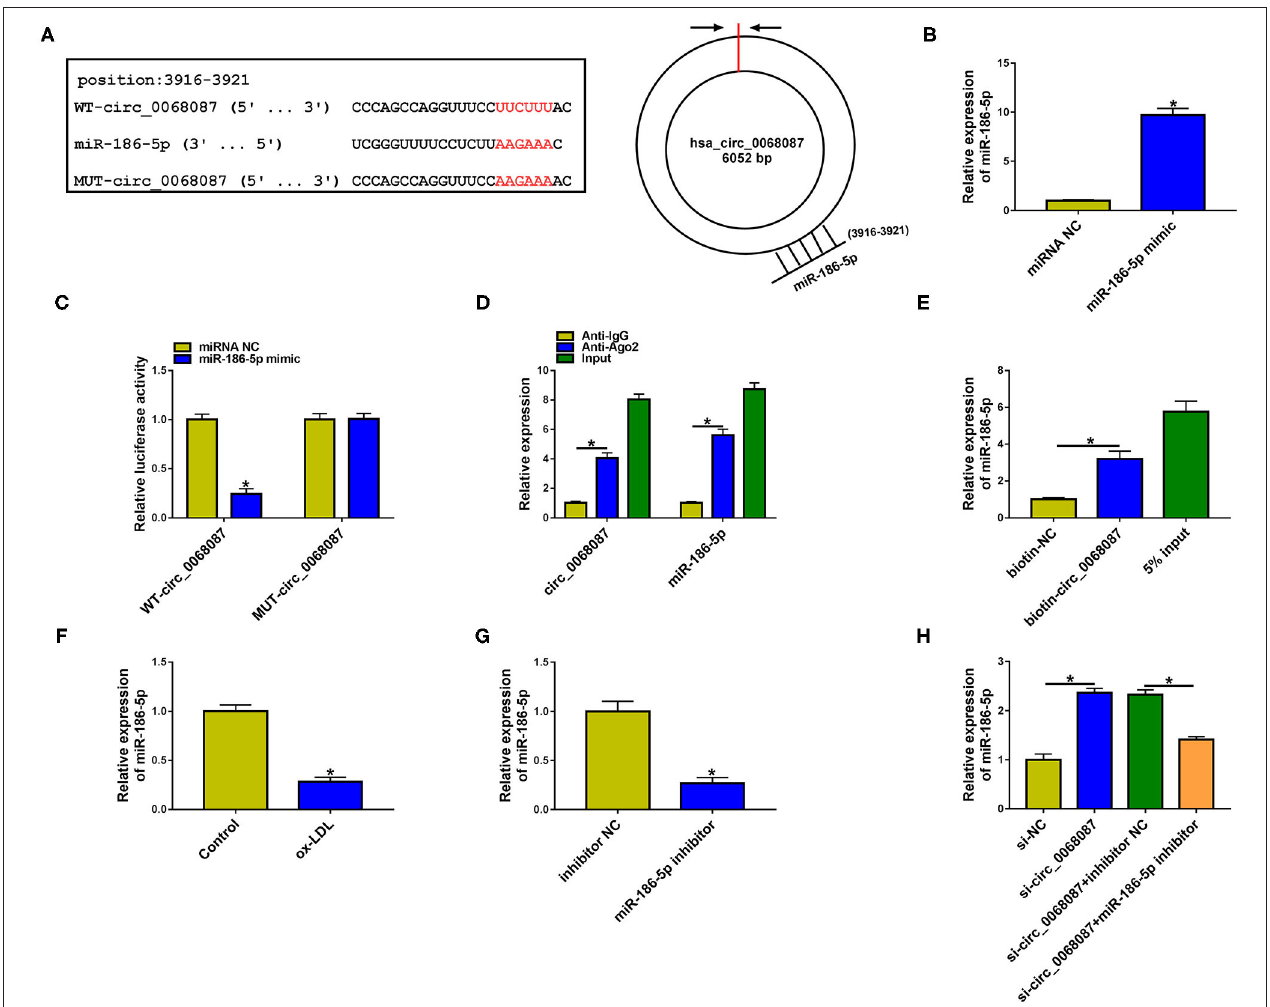
FIGURE 3 | Circ_0068087 acts as miR-186-5p sponge in HUVECs. (A) The putative binding sites between circ_0068087 and miR-186-5p were predicted by circinteractome and circBank. (B) The overexpression efficiency of miR-186-5p mimic in HUVECs was assessed by RT-qPCR. This experiment was performed three times with three technical repetitions each time. An unpaired Student t -test was used to evaluate the differences. (C,D) The predicted interaction between circ_0068087 and miR-186-5p was tested by dual-luciferase reporter assay and RIP assay. These two experiments were performed three times with three technical repetitions each time. An unpaired Student t -test was used to evaluate the differences. (E) RNA pulldown assay was applied to test the interaction between circ_0068087 and miR-186-5p. This experiment was performed three times with three technical repetitions each time. An unpaired Student t -test was used to evaluate the differences. (F) The level of miR-186-5p was measured in HUVECs exposed to 40 mg/L ox-LDL for 24h by RT-qPCR. This experiment was performed three times with three technical repetitions each time. An unpaired Student t -test was used to evaluate the differences. (G) The silence efficiency of miR-186-5p inhibitor in HUVECs was assessed by RT-qPCR. This experiment was performed three times with three technical repetitions each time. An unpaired Student t -test was used to evaluate the differences. (H) The expression of miR-186-5p in HUVECs transfected with si-NC, si-circ_0068087, si-circ_0068087 + inhibitor NC, and si-circ_0068087 + miR-186-5p inhibitor was tested by RT-qPCR. This experiment was performed three times with three technical repetitions each time. One-way ANOVA followed by Tukey’s post hoc test was used to assess the differences. * P <